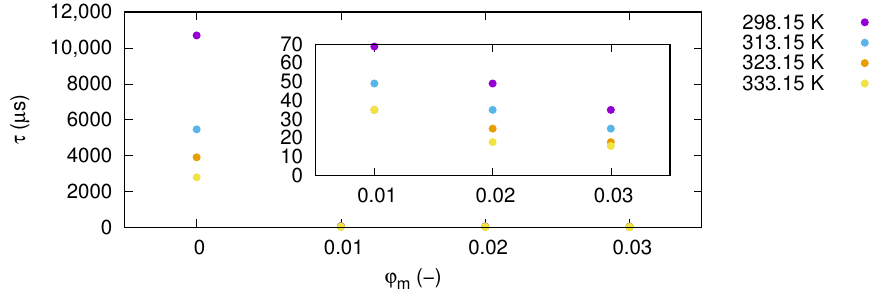
Figure 8. Variation of relaxation time SiO 2 -L-EG nanofluids as function of mass fraction for various temperatures. Inset presents magnification of results in mass fraction range from 0.01 to 0.03.